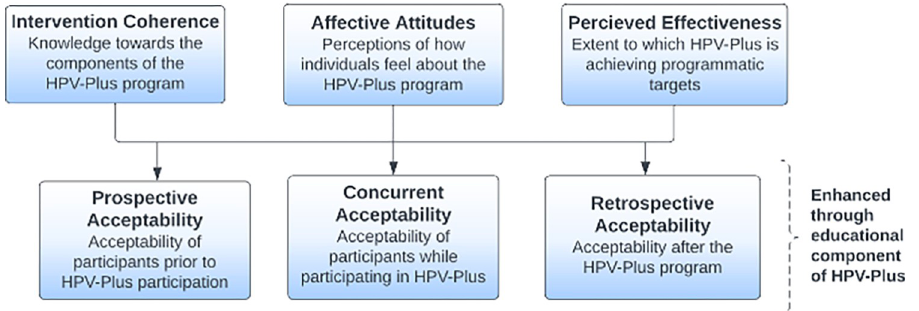
Fig 1. Theoretical framework of acceptability adapted for